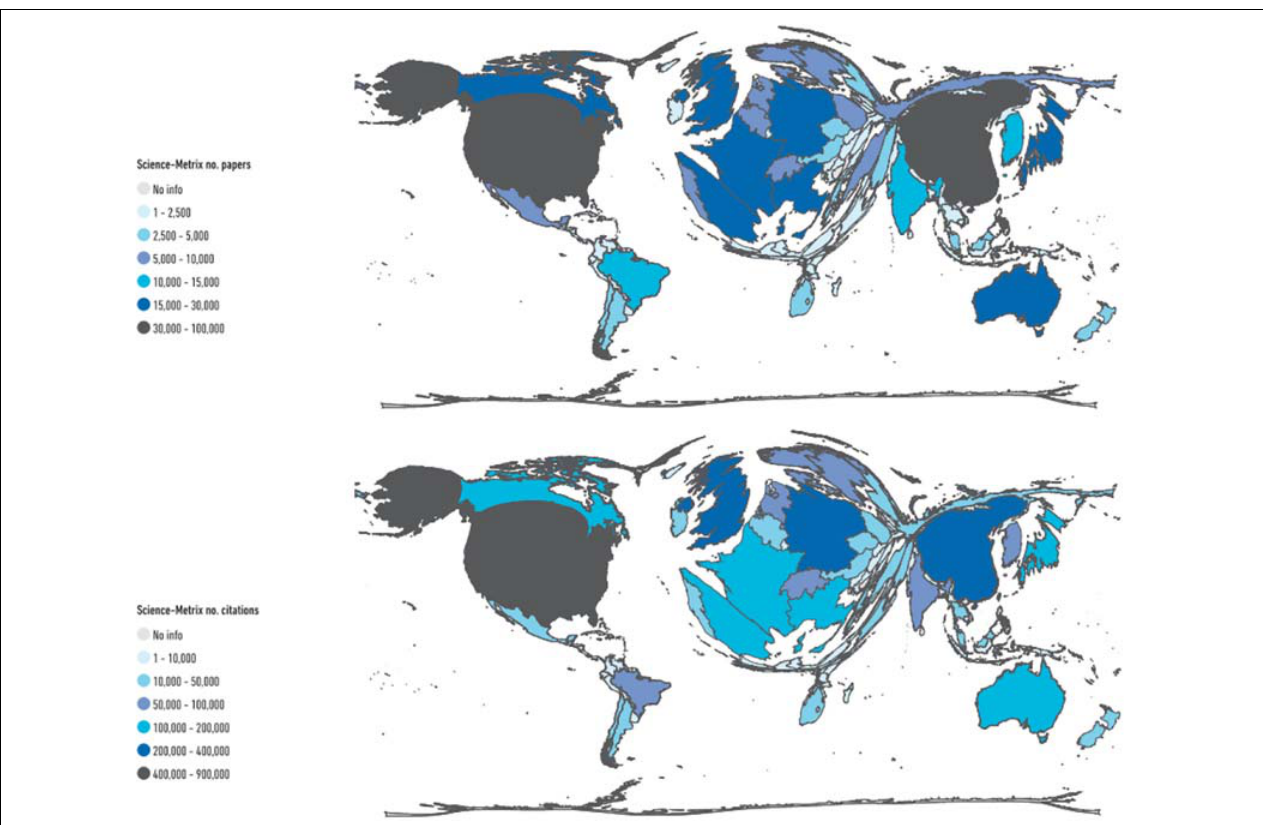
FIGURE 2 | Reproduced from the Global Ocean Science Report (IOC-UNESCO, 2017, p. 28). Original caption: “Publication and citation map of the world. The area of each country is scaled and resized according to the number of ocean science publications (top) or citations received (bottom). Different colors indicate a different number of publications (top) or citations